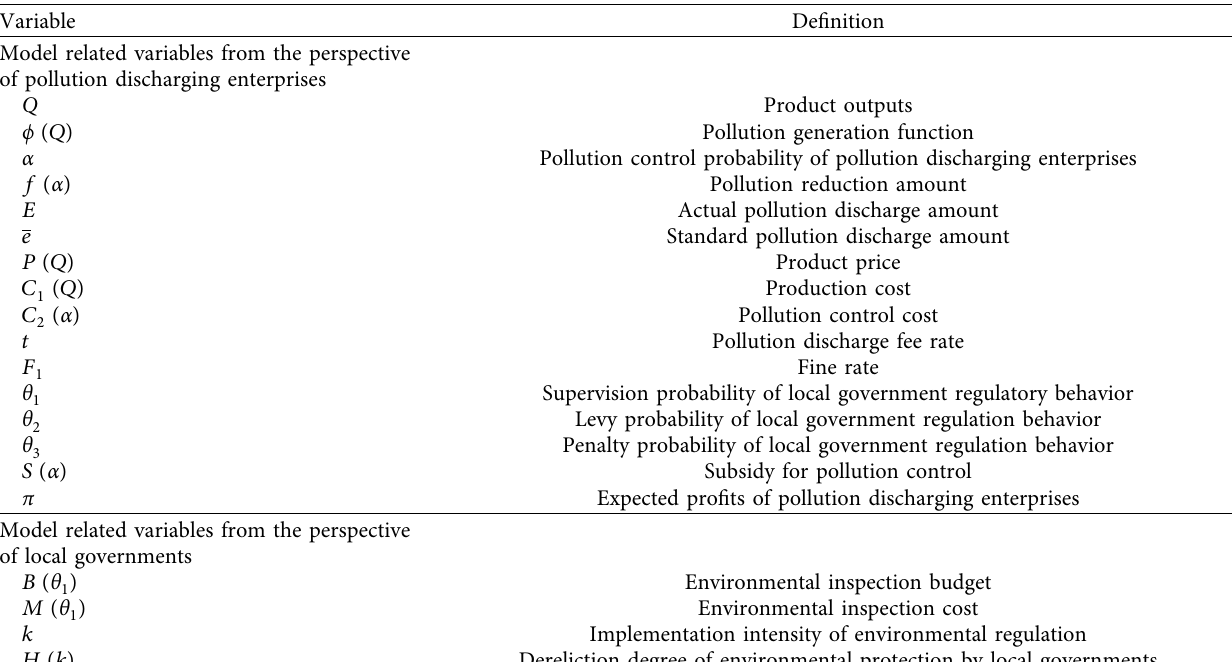
Table 1: Variables and